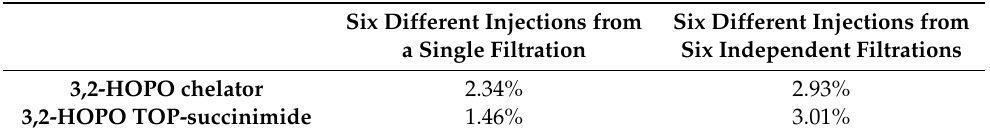
Table 2. Repeatability of the filtration protocol for 3,2-HOPO chelator and 3,2-HOPO